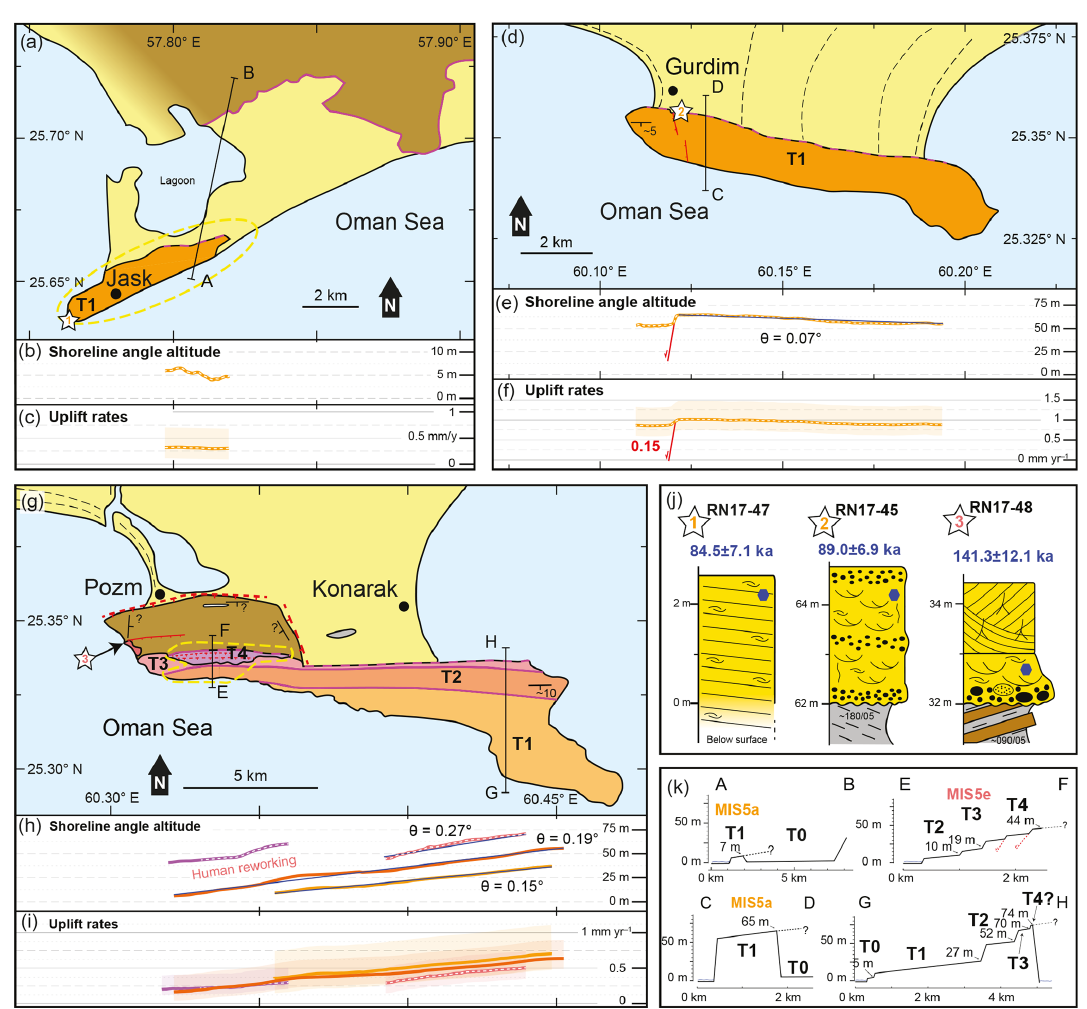
Figure 5. Terrace maps of the Jask, Gurdim and Konarak regions (see Fig. 1). (a) Terrace map of Jask. (b) Shoreline angle altitude in an east–west profile. (c) Uplift rates. (d) Terrace map of Gurdim. (e) Shoreline angle altitude in an east–west profile. (f) Uplift rates. (g) Terrace map of Konarak. (h) Shoreline angle altitude in an east–west profile. (i) Uplift rates. (j) Sedimentary log at sampling locations and sample OSL age (blue). (k) Altitude profiles through the